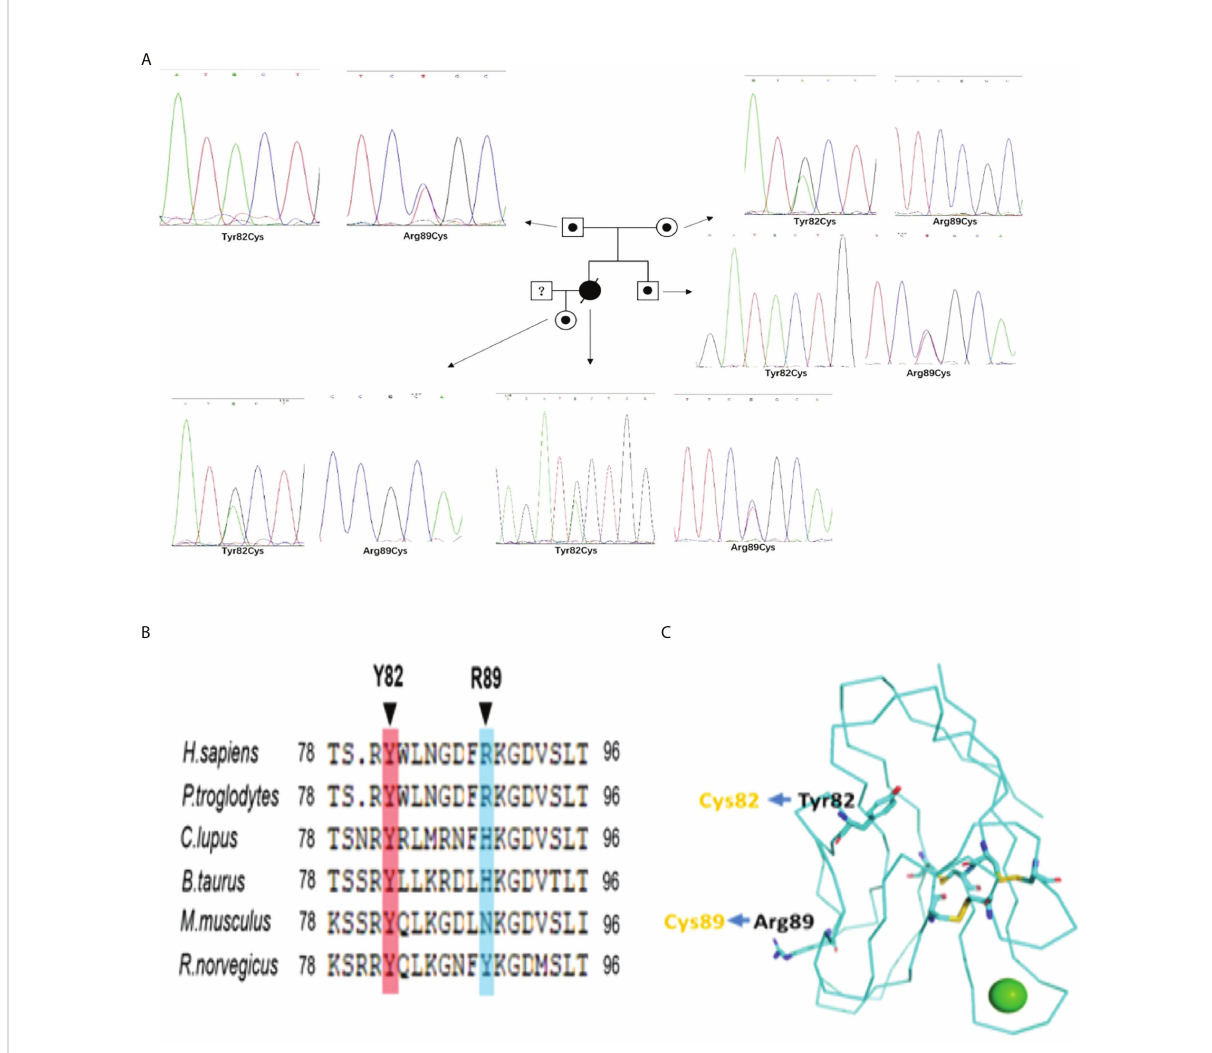
FIGURE 2 (A) The Pedigree diagram of the proband and corresponding sequencing results: Circles indicates female family members, squares indicates male family members, black small circle indicates singlely heterozygous mutation in TIM-3 gene; an black oblique line denote died of proband; Sanger sequencing pictures corresponding to the proband (Y82C and R89C compound heterozygous mutations) and her familial members(with singlely heterozygous mutation) in TIM-3 gene;1. (B) Sequence alignments in different species indicating homology of the mutated residues in TIM-3 protein;1. (C) Structure of the human TIM-3 IgV domain indicates the sites of the misfolding substitutions at Tyr82 and Arg89,and lead to TIM-3 protein misfolding aggregation(Protein Data Bank ID: